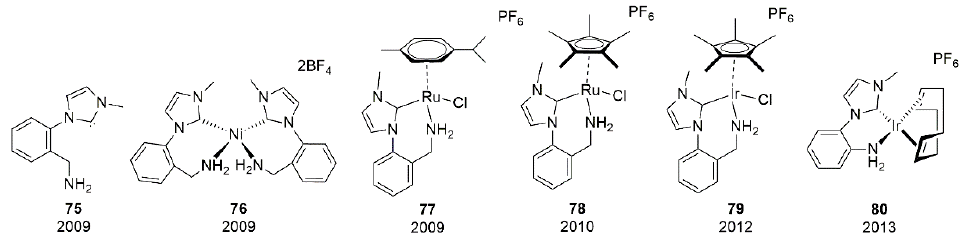
Figure 5. Metal complexes of NHC ‐ NH 2 chelates [134–139].